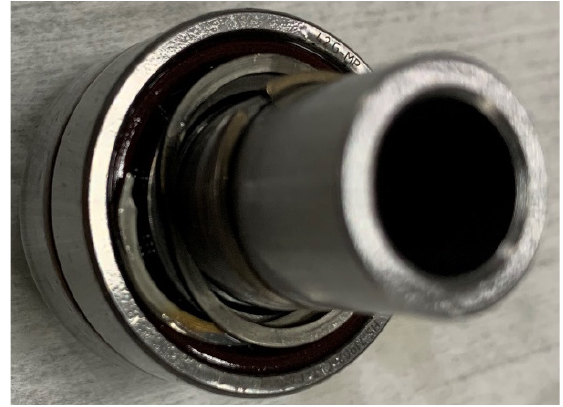
Figure 6. The failure of the coaxial-rotor bearing circlip.